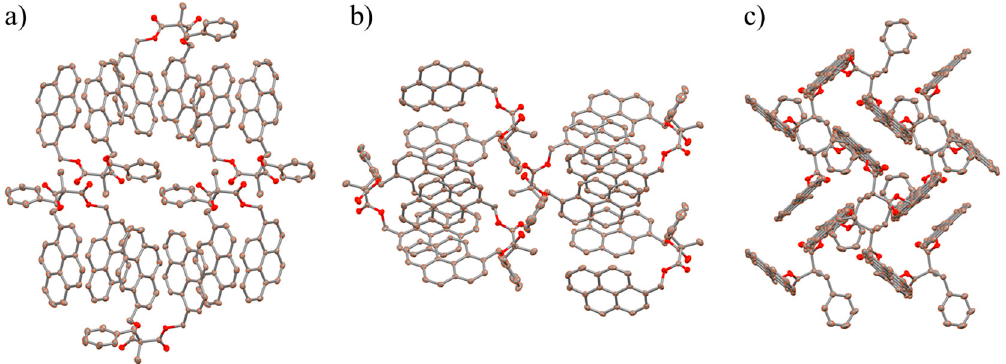
Figure 3. ( a ) Projection down the a axis; ( b ) projection down the b axis; and ( c ) projection down the c axis of the molecular packing of bispyrenyl malonate 1 .